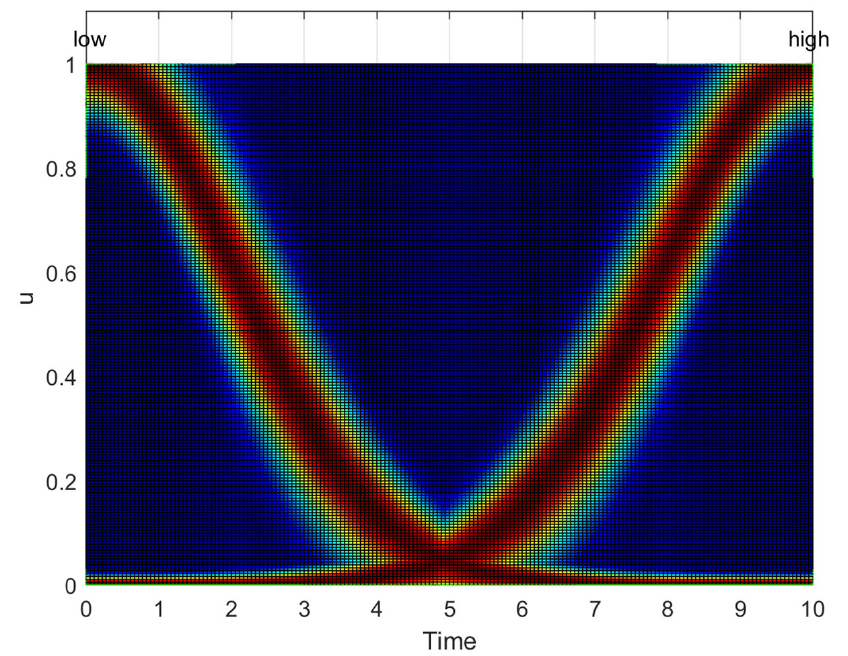
Figure 7. Nonmembership functions of the time input variable.